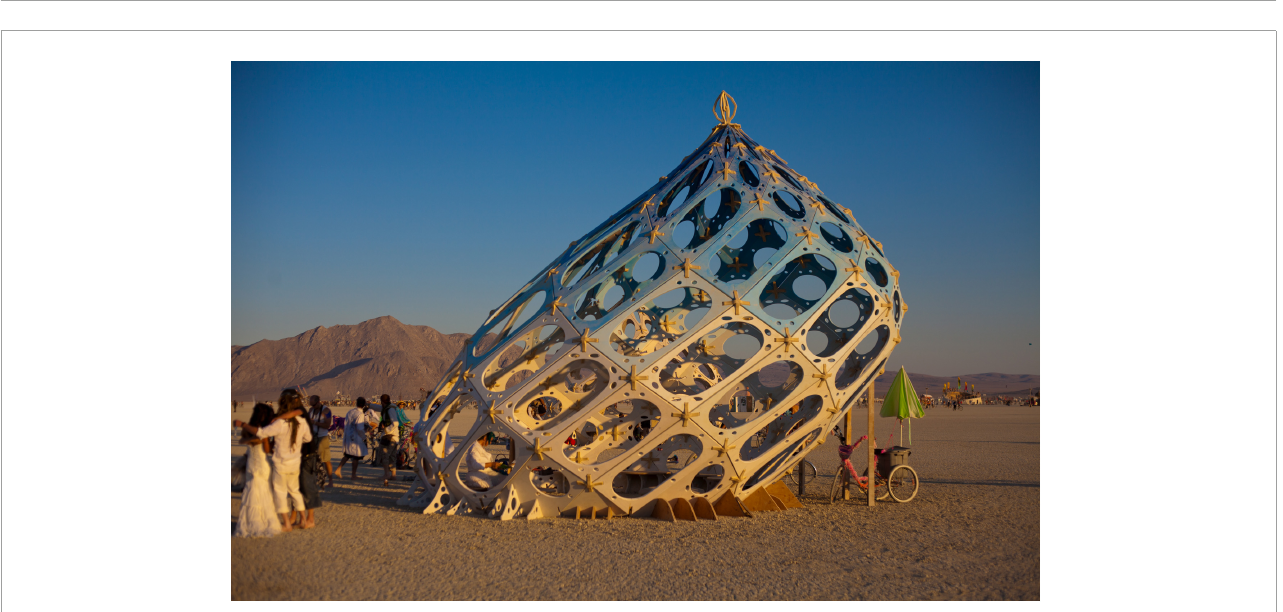
FIGURE2 A bio-tensegrity structure with imbalance. Nerves can be affected by internal fascial forces and sense tension to send pain signals. This happens more in weaker areas of the structure, i.e., areas that are pulled by myofascial tissue and myofibroblast generated forces, for example, as seen on the right side of the structure when the dome is facing the observer. Needling the painful area does not address the underlying cause for the pain, which may be increased tension generated by the left side of the structure (when facing the observer). To balance the structure, one should needle the contralateral side to pain as well: the side to which the structure leans and which indicates more stress shielding and force generation. In this model, pain and somatic manifestations are a symptom of imbalance rather that the problem to simply target anatomically. With permission from, and photographed by, Aaron Neilson-Belman AaronNeilsonBelman.com. Reprinted from https://hippievanman.com/photos (accessed